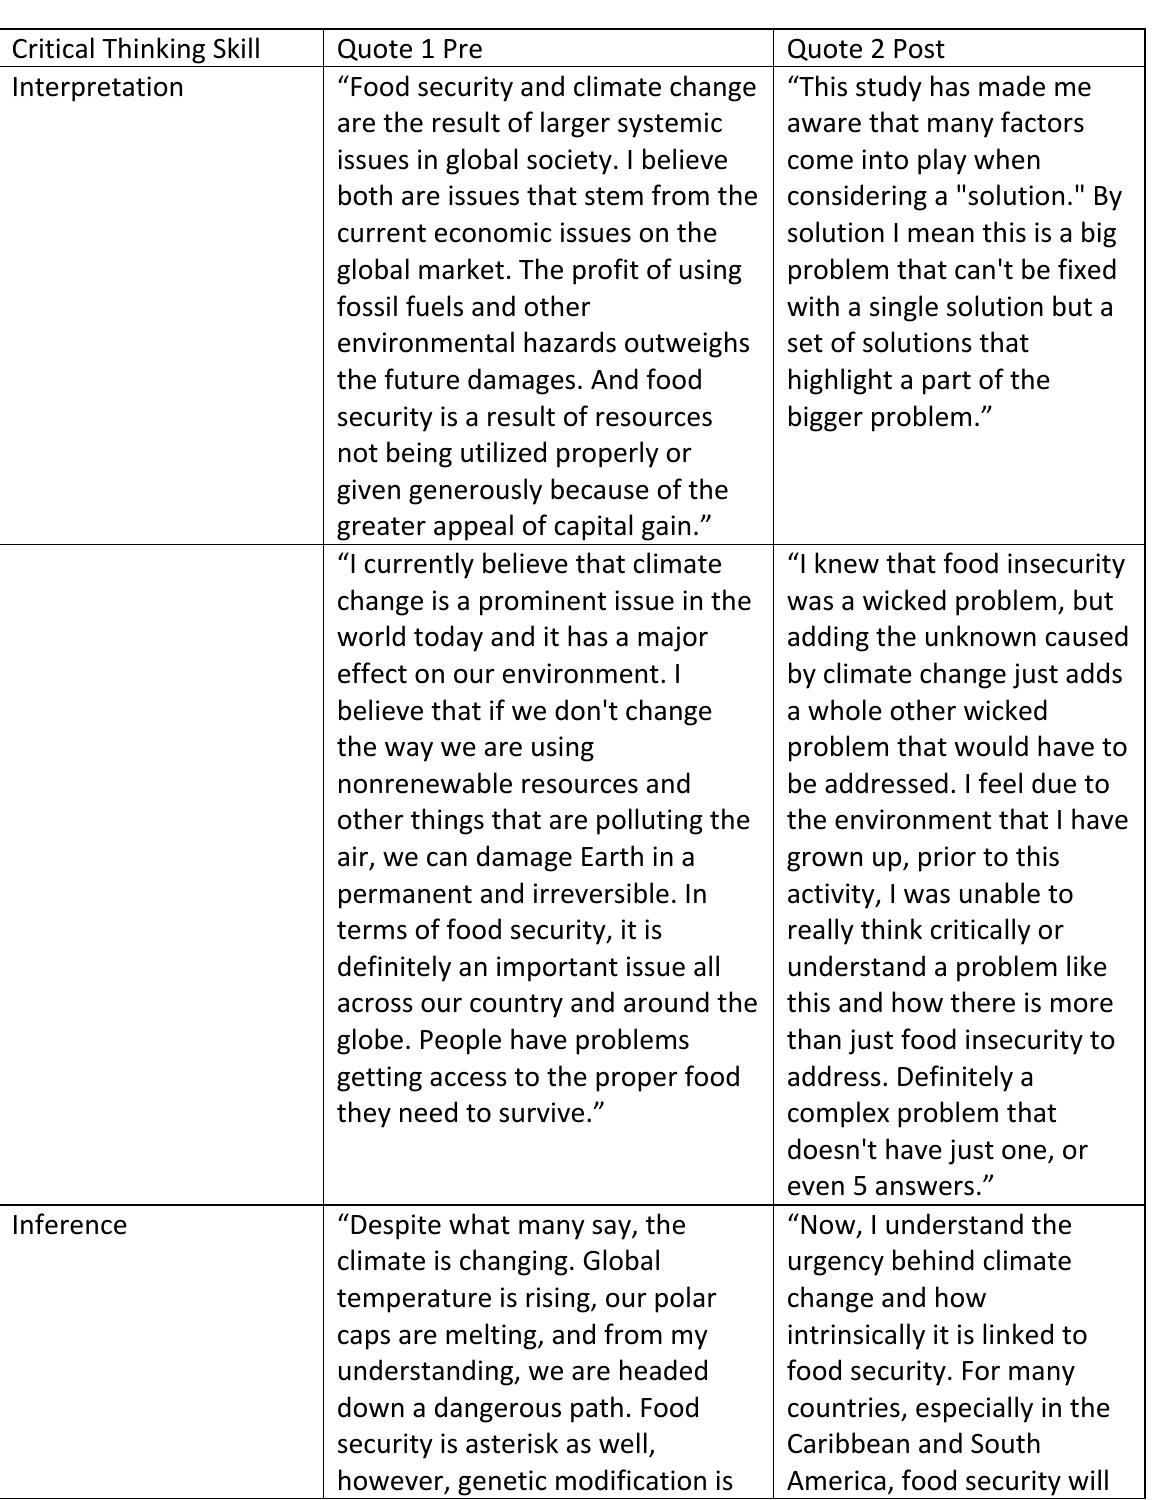
Examples of student statements illustrating critical thinking skill ( n